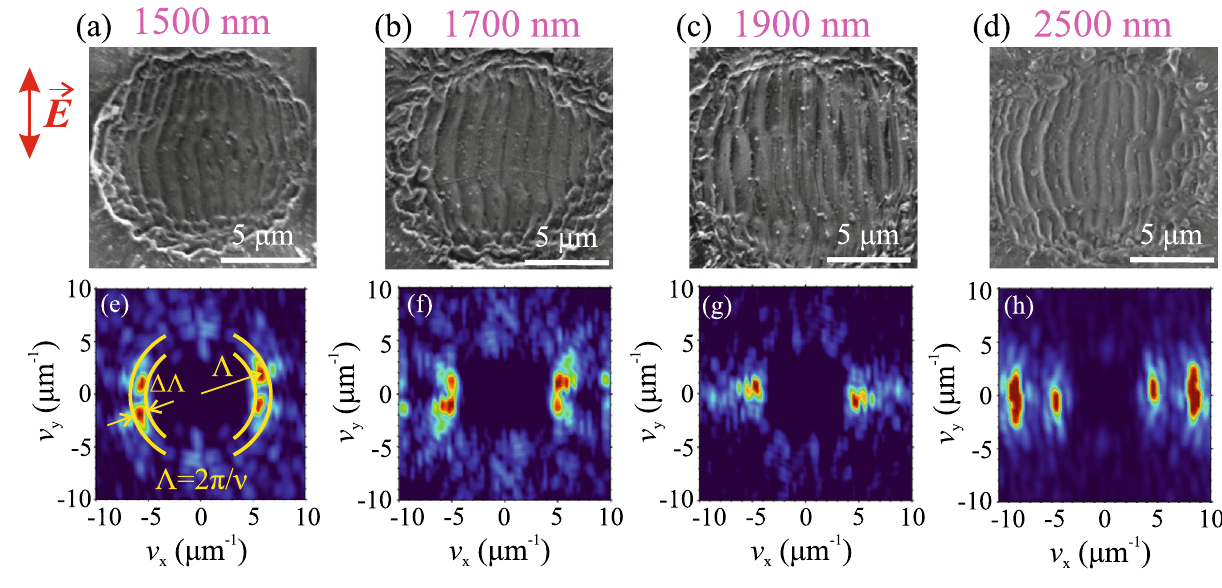
Figure 3. SEM images of LSFL in fused silica, inscribed with OPA pulses having central wavelengths of ( a ) 1500 nm, ( b ) 1700 nm, ( c ) 1900 nm and ( d ) 2500 nm pulses. ( e–h ) The corresponding spatial frequency spectra retrieved by 2D-FFT. The red arrow indicates polarization direction of the incident laser pulse.